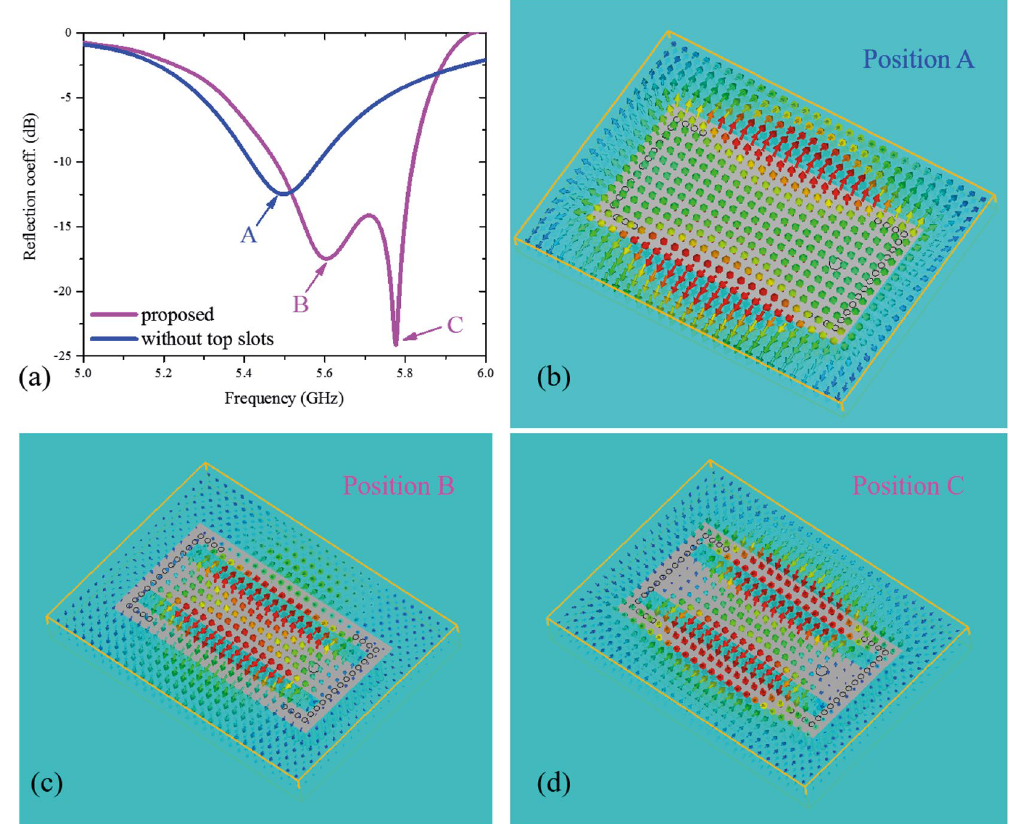
Figure 4. Operational principle of the dual-mode bidirectional antenna. ( a ) Reflection coefficients of the antenna shown in Fig. 3 with and without top slots. When there are two slots on the top patch, as shown in Fig. 3, two resonant points can be seen. When there is no top slot, only one resonant point can be seen. Electric field distributions at Positions A, B, and C are shown in ( b ), ( c ), and ( d ), respectively. The modes at Positions A and B are TM12 mode, and the mode at Position C is TM14 mode.